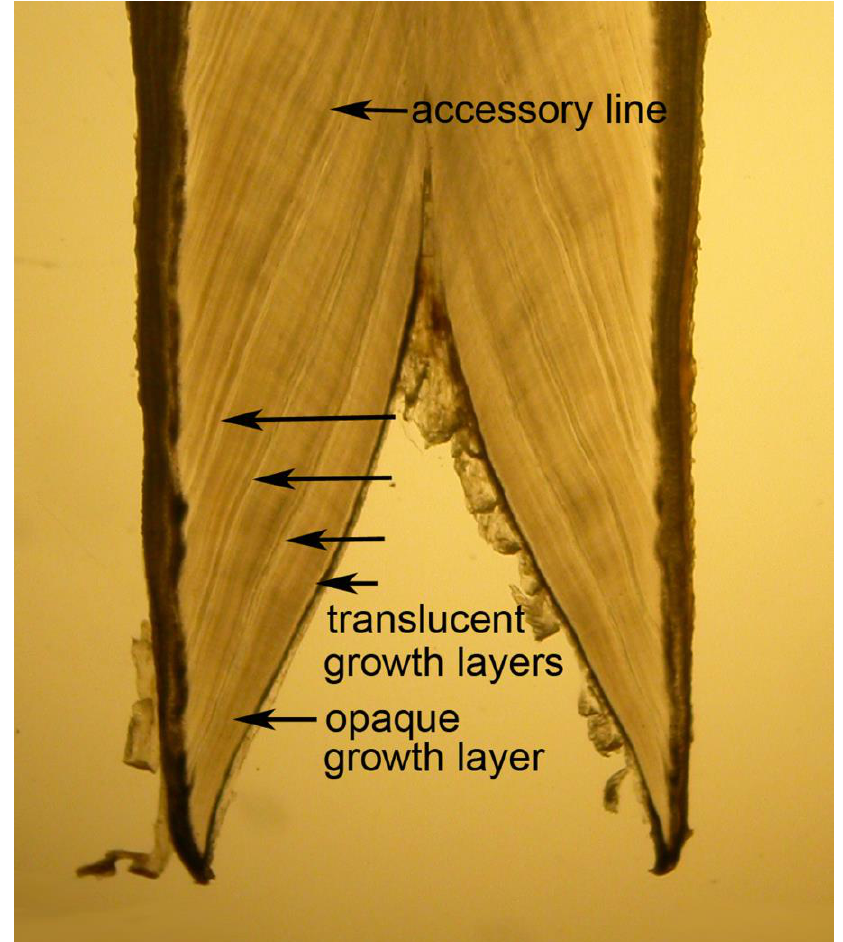
Fig. 8. The last-formed growth layer adjacent to the pulp cavity is translucent. PAU04-12, MNR-5. A translucent growth layer adjacent to the pulp cavity indicates the end of a GLG cycle, so age is the total GLG count, assuming fetal dentine is present and all GLGs could be counted. The opaque line between the last translucent growth layer and the pulp cavity is edge effect. Accessory lines are apparent in the opaque growth